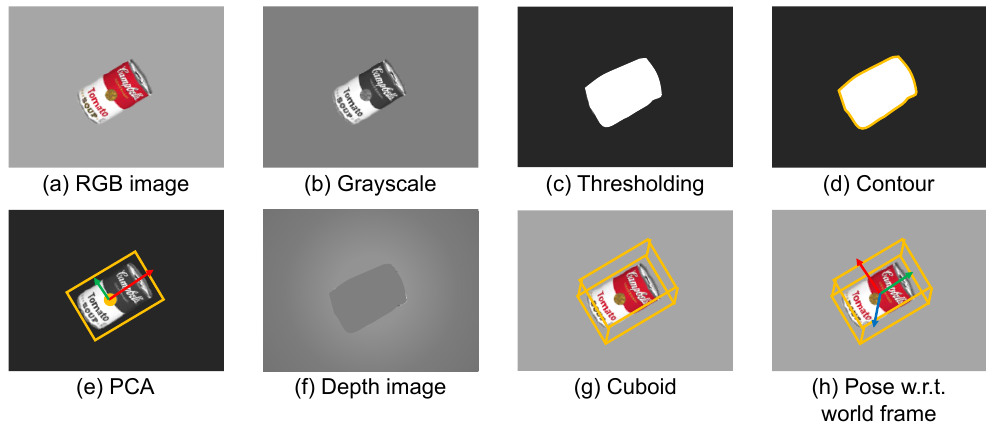
Figure 9. Graphical overview of the vision